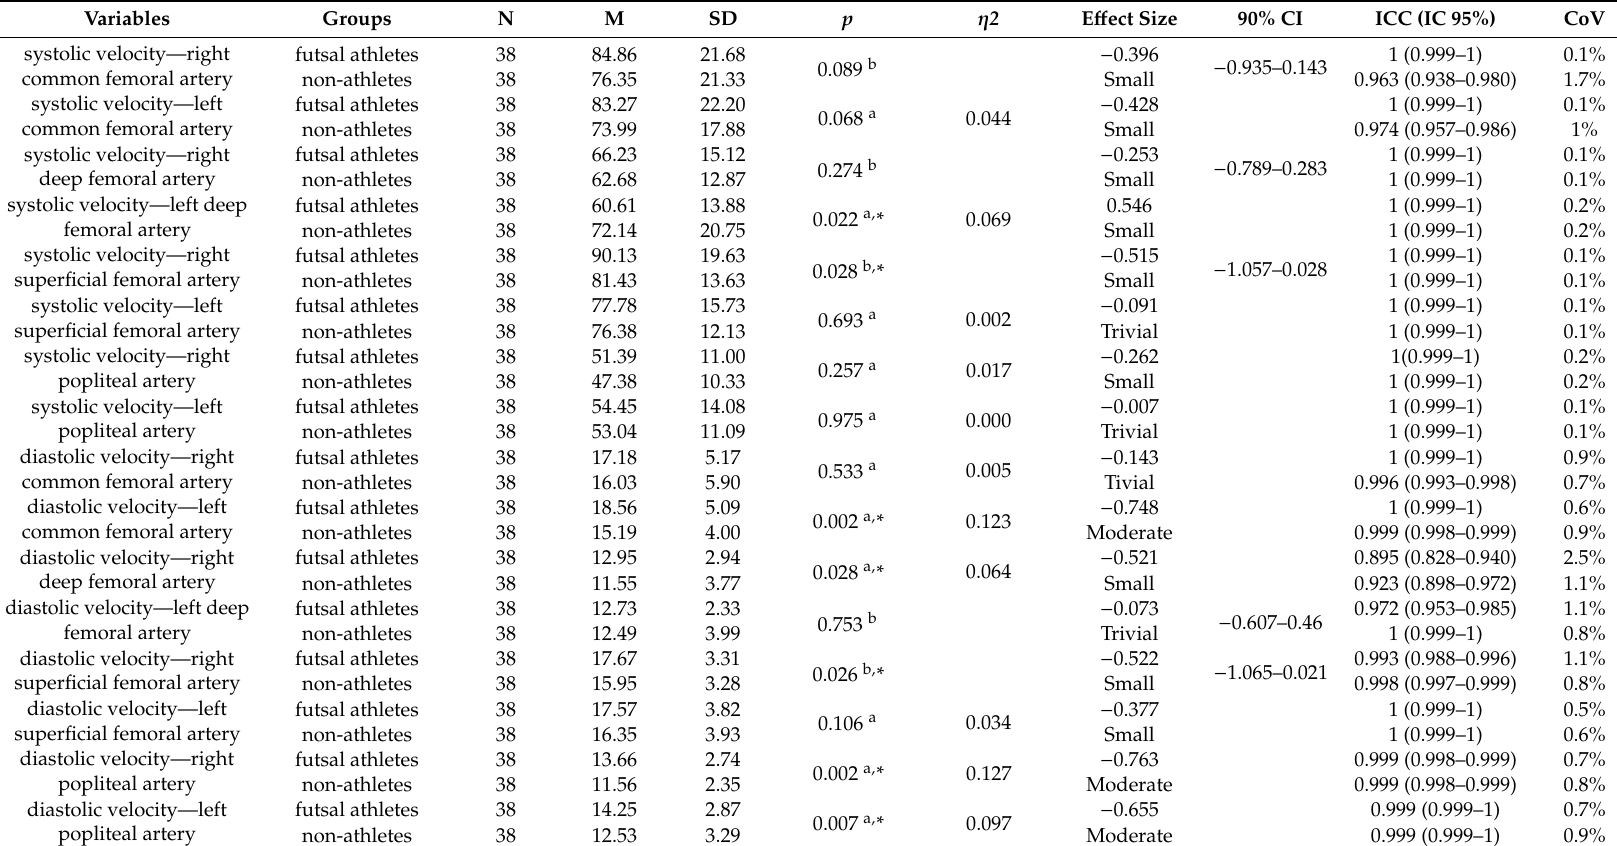
Table 1. Descriptive statistics, di ff erences between groups, and e ff ect size in variation of systolic and diastolic